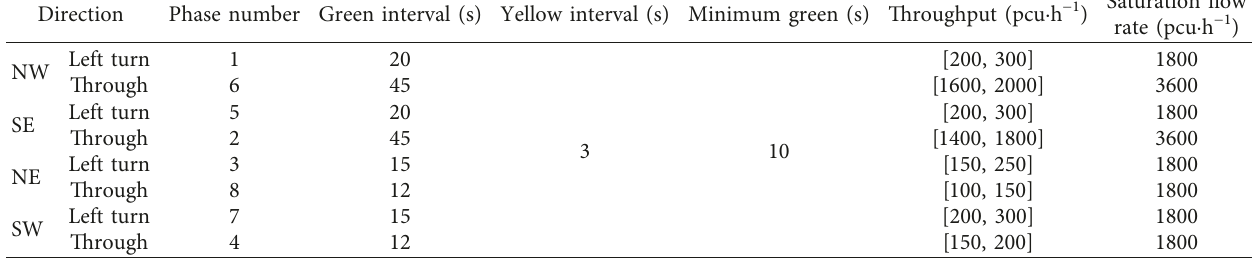
Table 1: Basic parameters at the